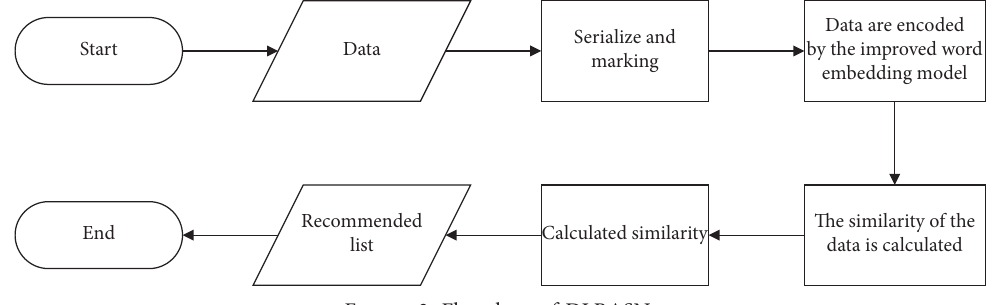
Figure 3: Flowchart of